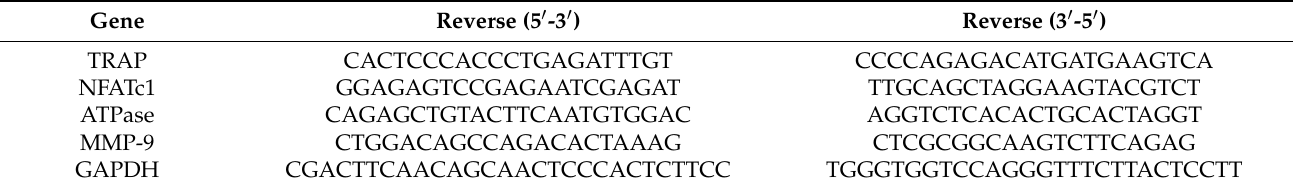
Table 1. Sequences of primers for PCR